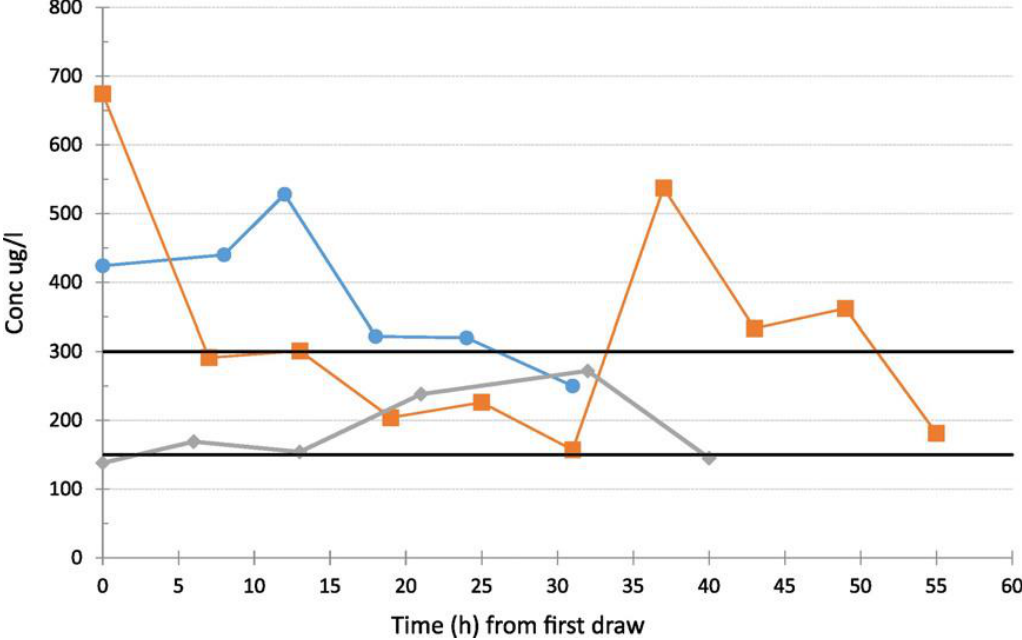
Figure 8. Milrinone serum concentration time profiles for 3 patients post-cardiac surgery (marked in orange, blue, grey). Solid black line at 150 and 300 μg/L indicate therapeutic range [105].